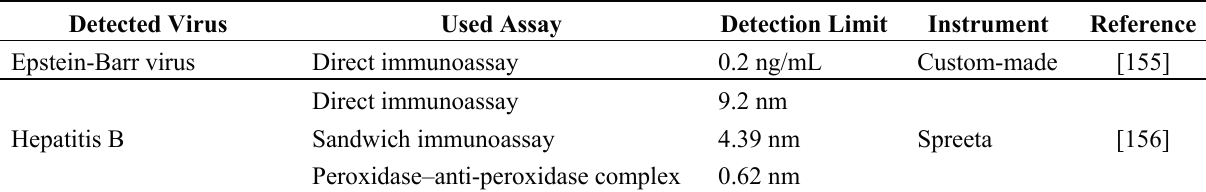
Table 6. SPR biosensors for virus